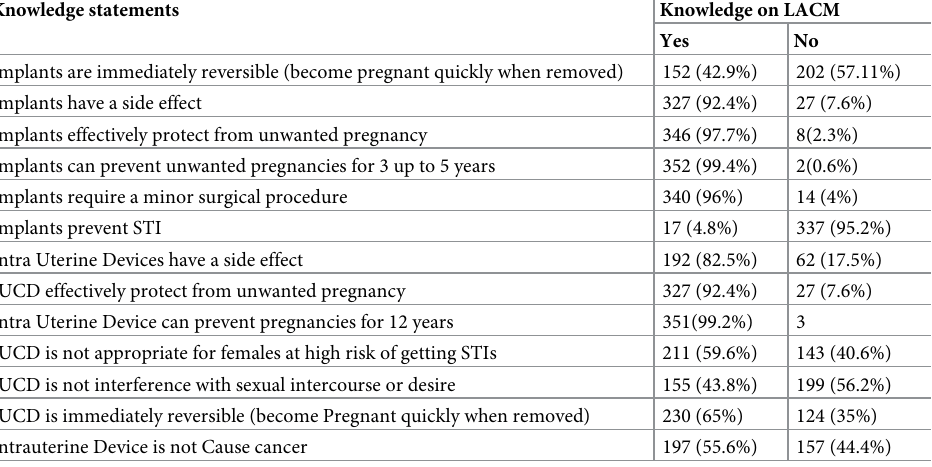
Table 5. Knowledge of long-acting contraceptive methods among female healthcare providers in South Wollo Zone governmental hospitals, 2021 (n =